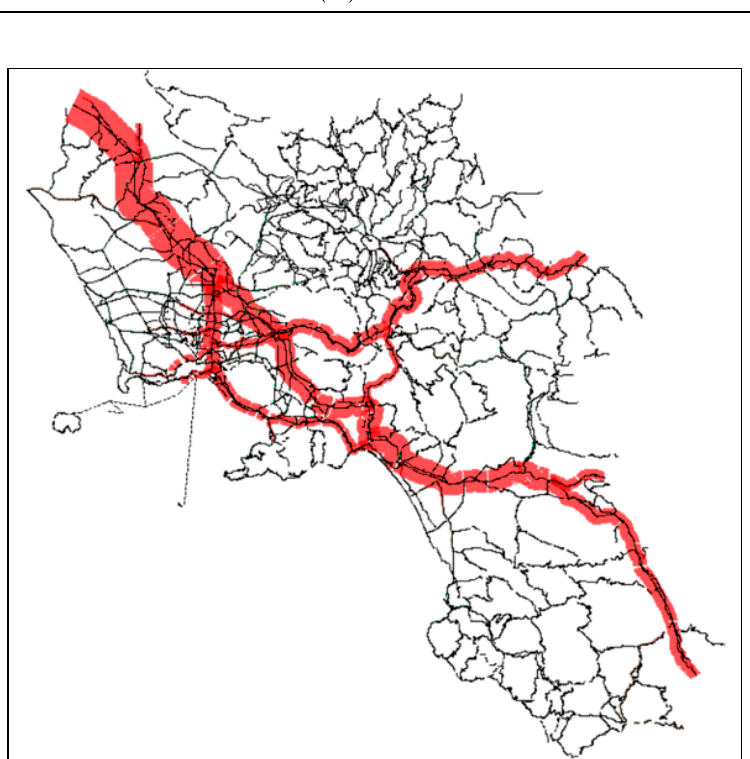
Figure 12. Estimated traffic flows (regional model). Table 4. Free-flow speed for HGVs (regional model) [4].